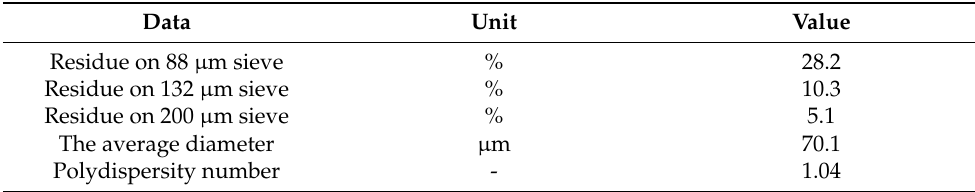
Table 2. Coal granulation — main burner — 1st and 2nd row.